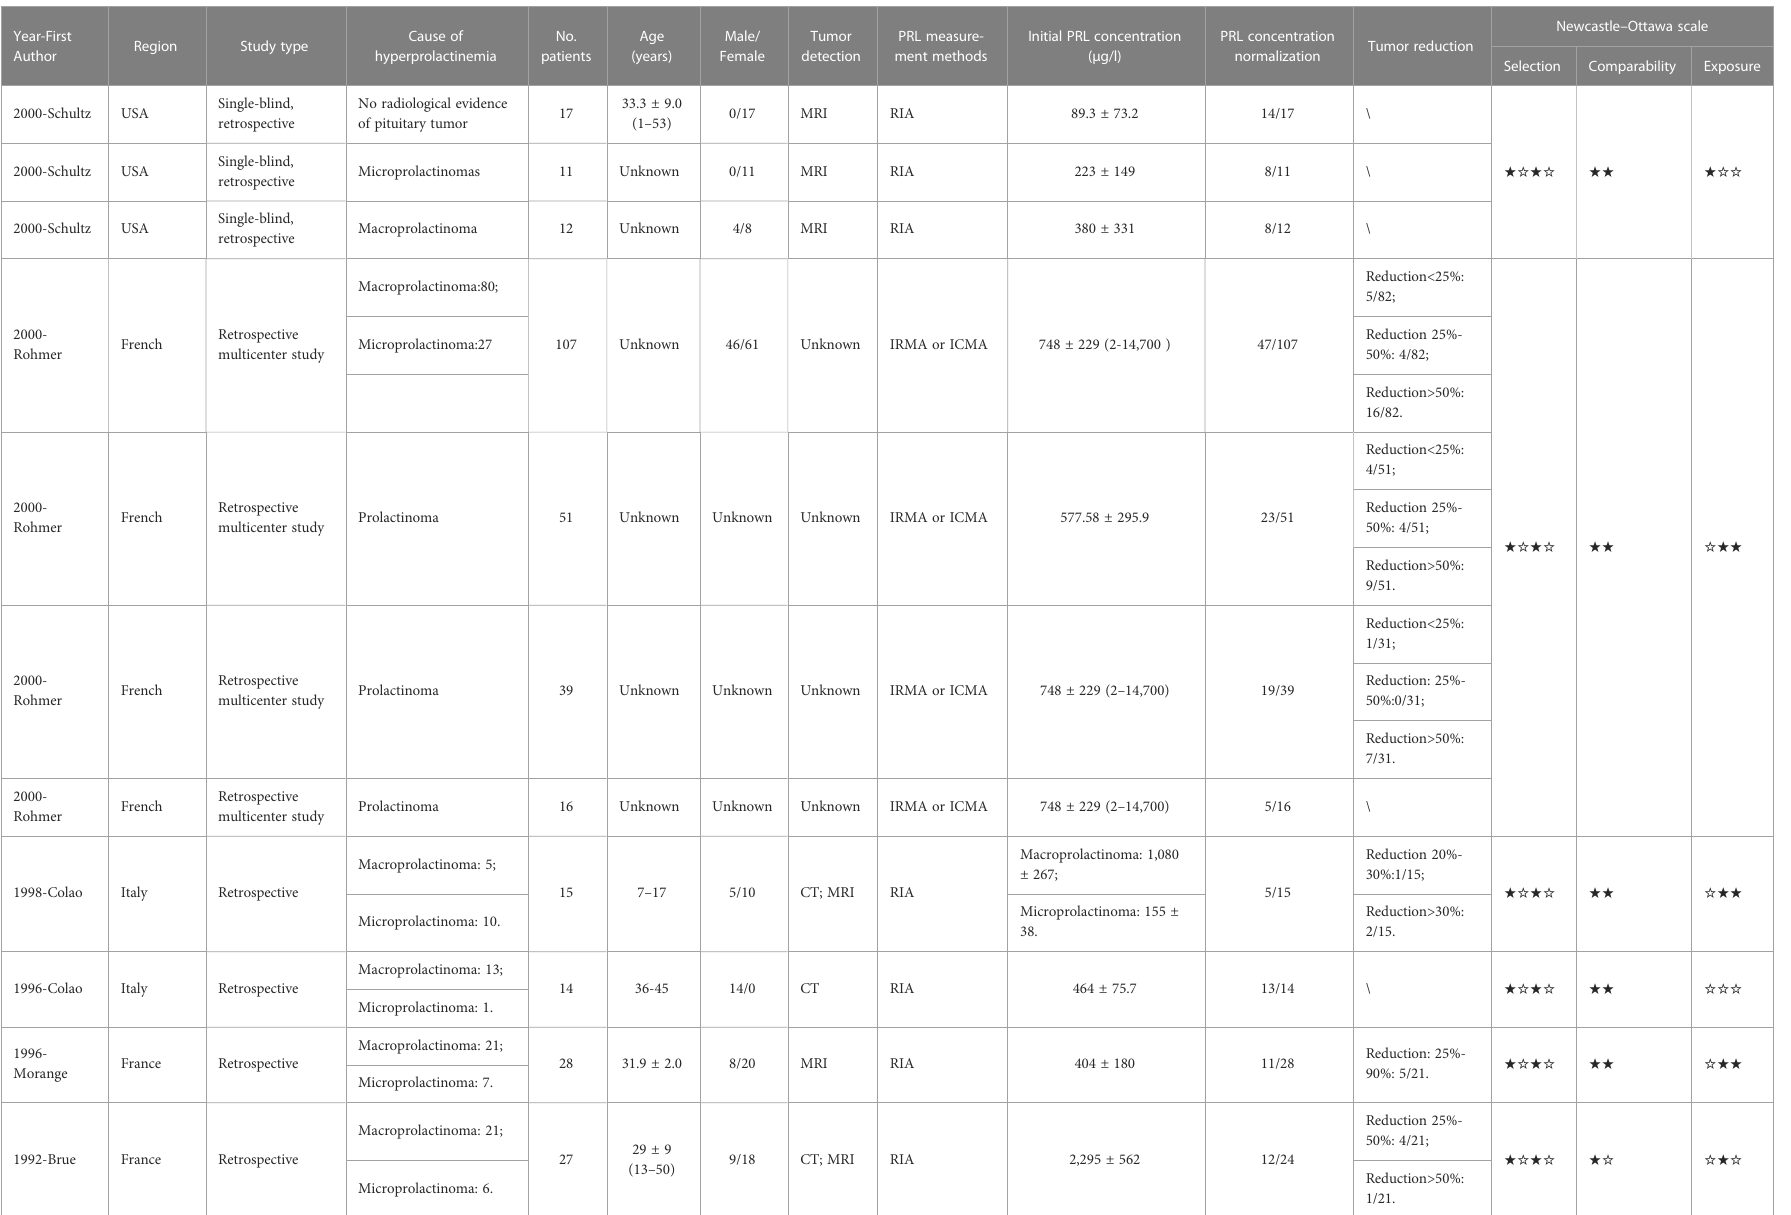
TABLE 2 Characteristics, Cochrane risk of bias, and Newcastle – Ottawa scale of included studies with single